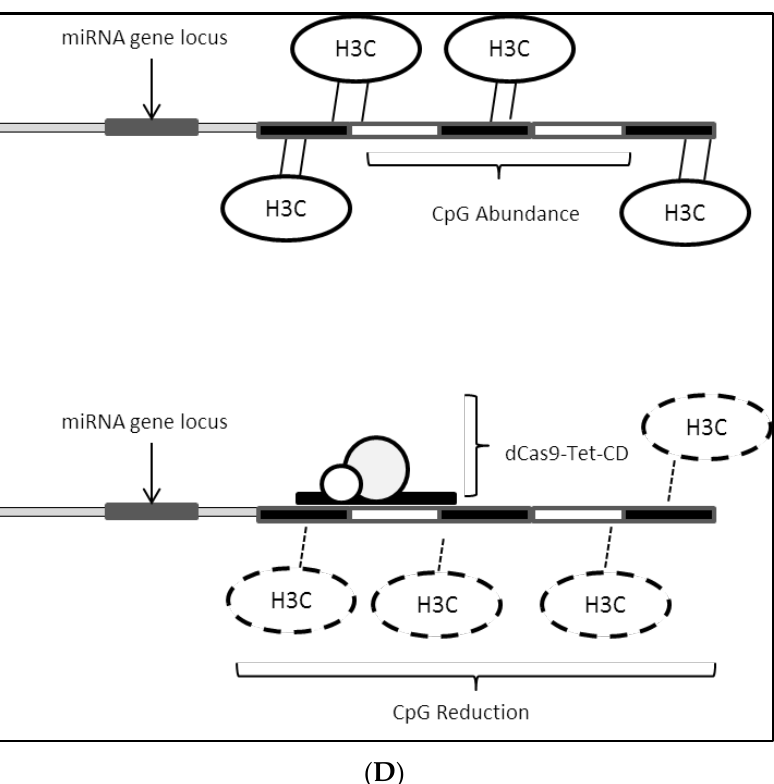
Figure 6. ( A ) Using dCas9 to block transcription elongation. TFs: transcription factors; Pol II: RNA polymerase 2; ( B ) Using the nickase strategy to cut amplified loci. HDR: homology-directed repair; ( C ) Relieving the epigenetics state of miRNA locus to increase gene transcription. Act: Acetyl group; p300: Histone modifier; ( D ) Modulation of the CpG methylation to induce miRNA expression. Modulation of the CpG methylation to induce miRNA expression. H3C: methyl group.